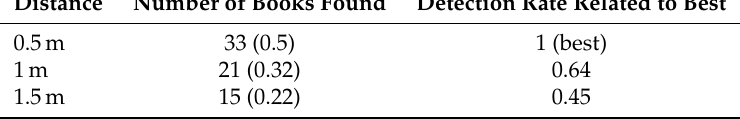
Table 3. Number of books found in the experiment poster shelf containing 66 books at different distances (including the detection rate). The detection rate in the last column is the number of books found related to the number of books detected in the best case of our experiments, i.e., 33 books at a distance of